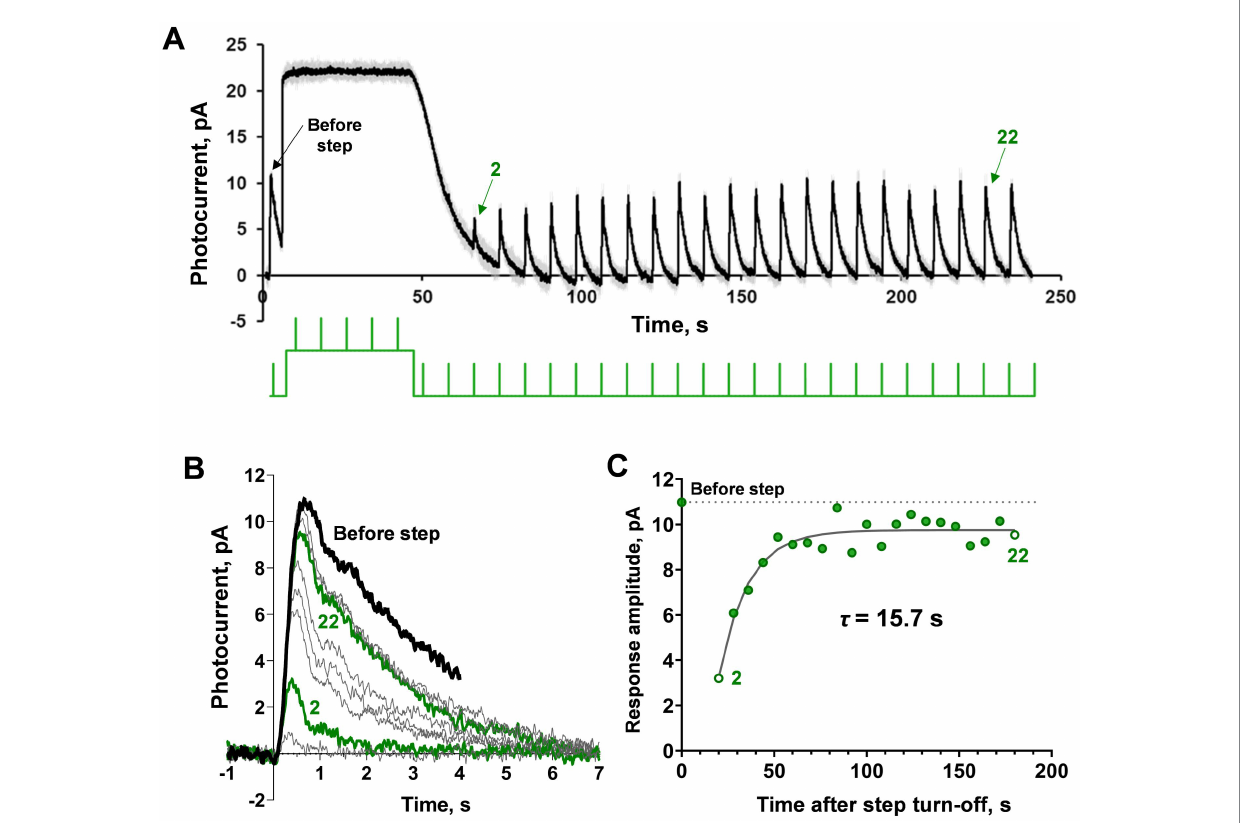
FIGURE 1 Demonstration of ‘adaptation memory’ phenomenon in frog rods. (A) Example of current recording from the isolated frog rod under our light stimulation protocol that combined a saturating light step with brief (2 ms) subsaturating flashes. The black solid line is rod current (averaged from 2 records obtained under the same protocol and smoothed with a moving average filter with a 40 ms window); gray lines represent the original raw recordings; the green line is the light stimulation protocol. (B) Single responses cut from record (A) and superimposed for shape comparison. The bold black curve corresponds to pre-step photoresponse, and the green bold curves are the second and 22nd photoresponses recorded after the step turn-off. (C) Estimation of the amplitude (sensitivity) recovery rate. The dashed line indicates the pre-step level of response